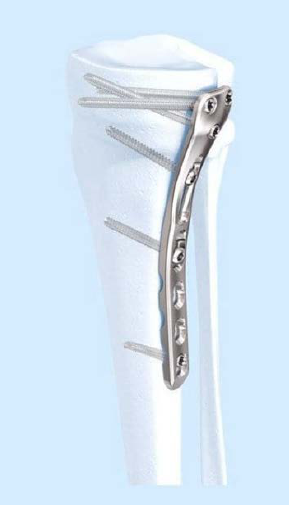
Figure 1. A common tibial locking compression plate (LCP) [13].